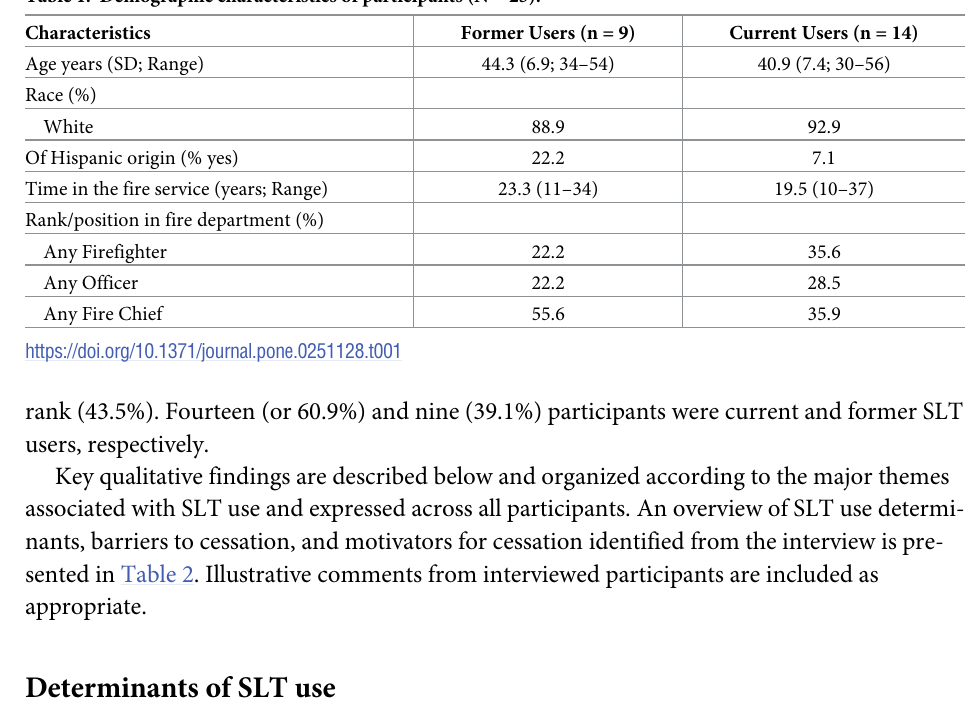
Table 1. Demographic characteristics of participants (N =